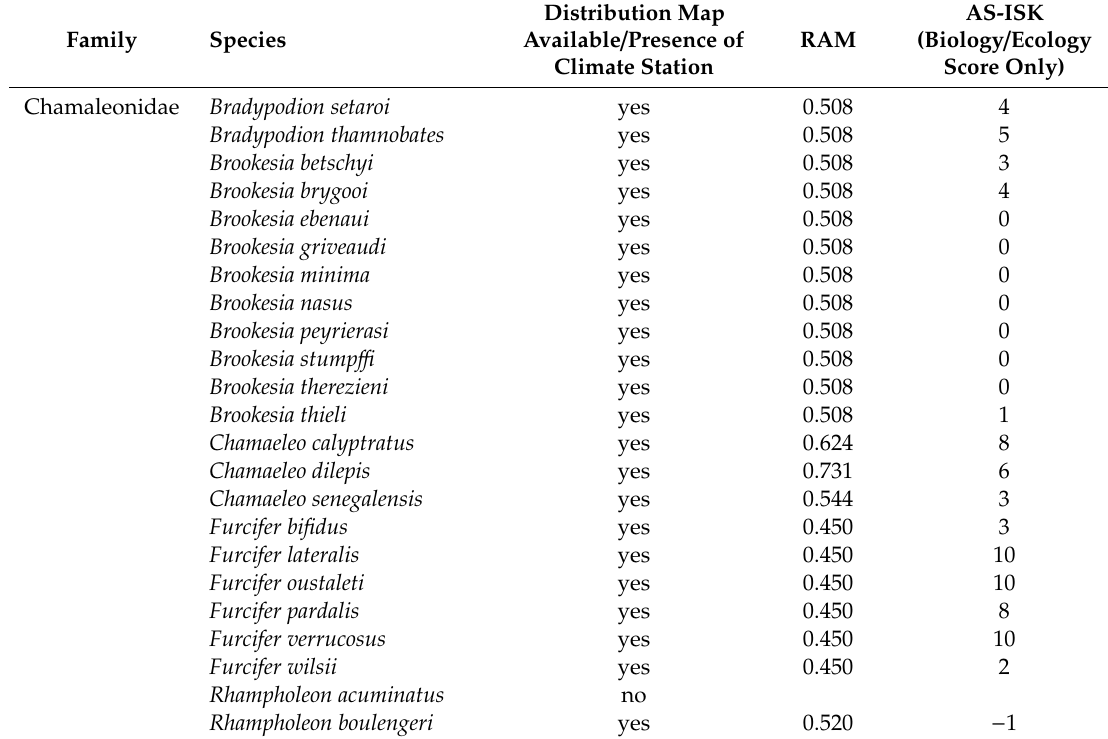
Table A1. Species of ornamental reptiles (excluding turtles) imported into EU with values of their RAM score (determining establishment potential in EU) and AS-ISK (determining potential to negatively influence nature in the